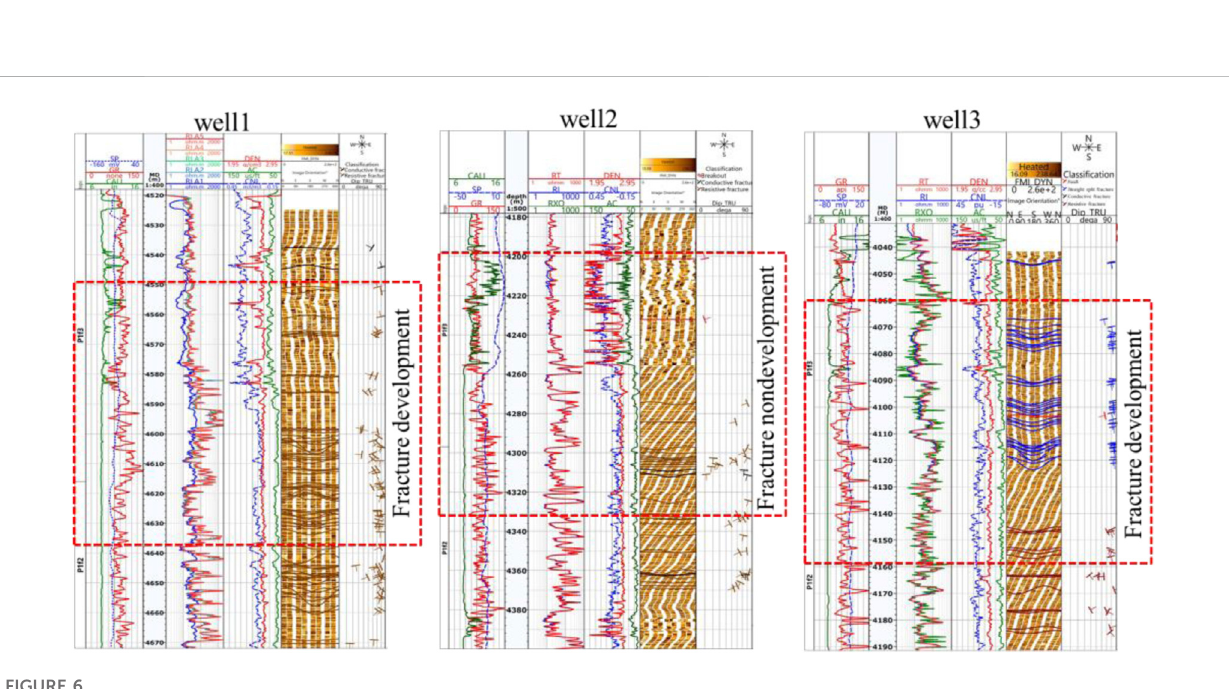
FMI logging of fracture density of the third member of Fengcheng Formation in Mabei